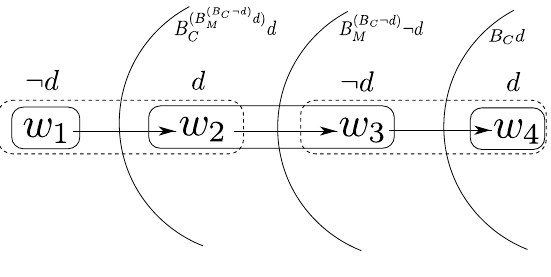
Figure 1. Cobb and Mal on the window